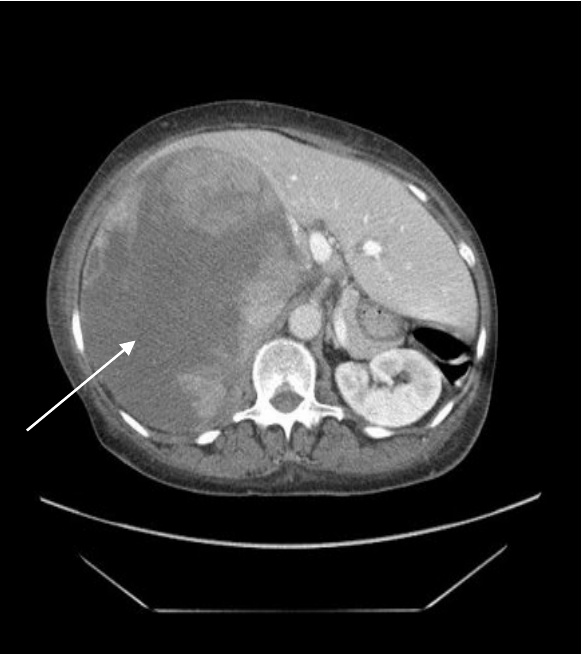
Figure 1. Contrast-enhanced CT scan of the abdomen and pelvis, axial view. Large heterogeneous mass visualized (arrow).